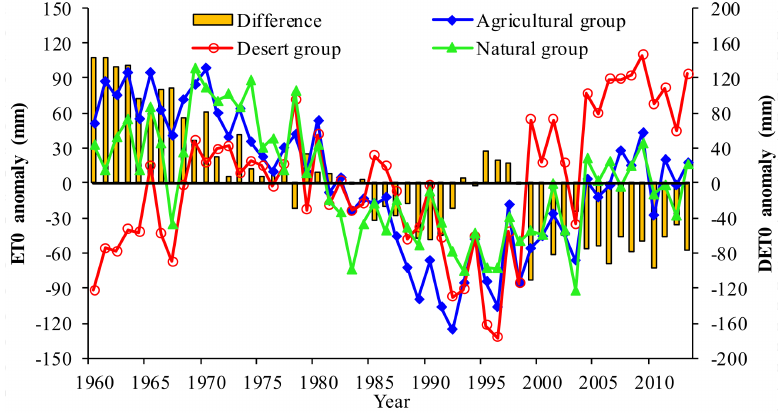
Figure 6. Time series of average annual ET0 anomalies for the different station groups, 1960–2013. The difference indicates the ET0 anomaly differences between the agricultural group and the desert group.